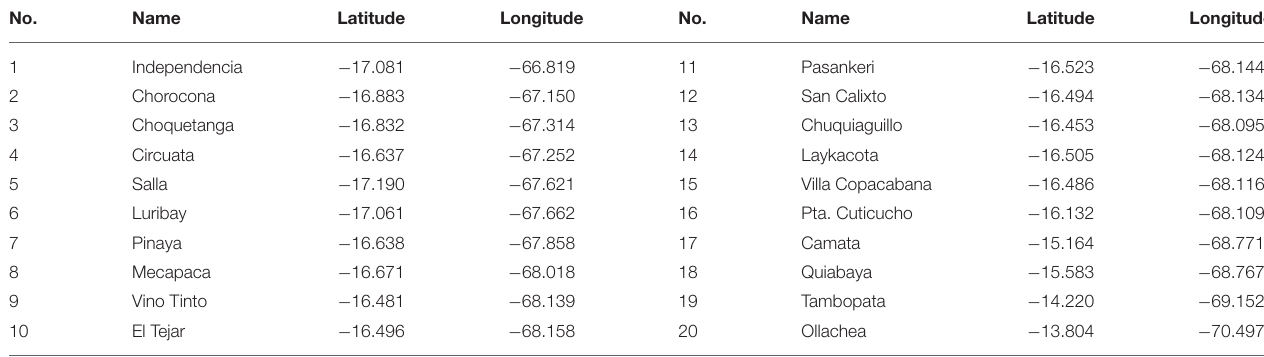
TABLE 1 | Homogenized rain gauge stations at the Andean Madeira basin for the 2003–2013 period.